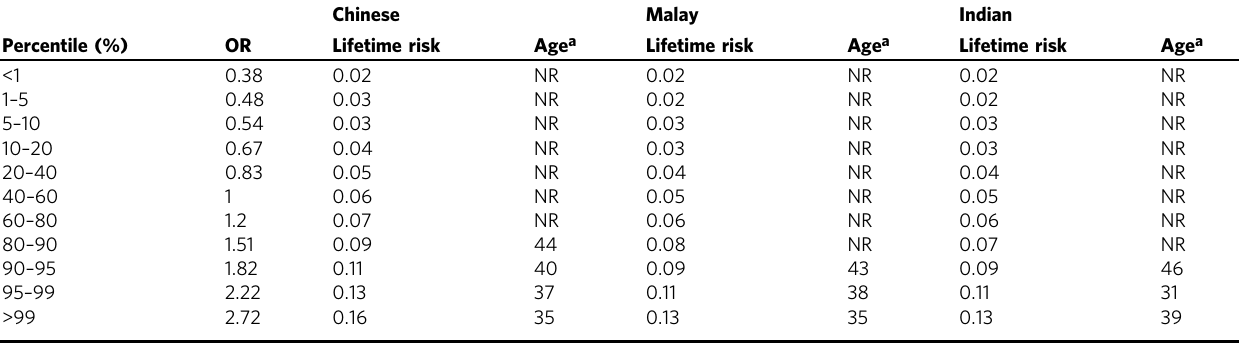
Table 5 Absolute risk of developing overall breast cancer by